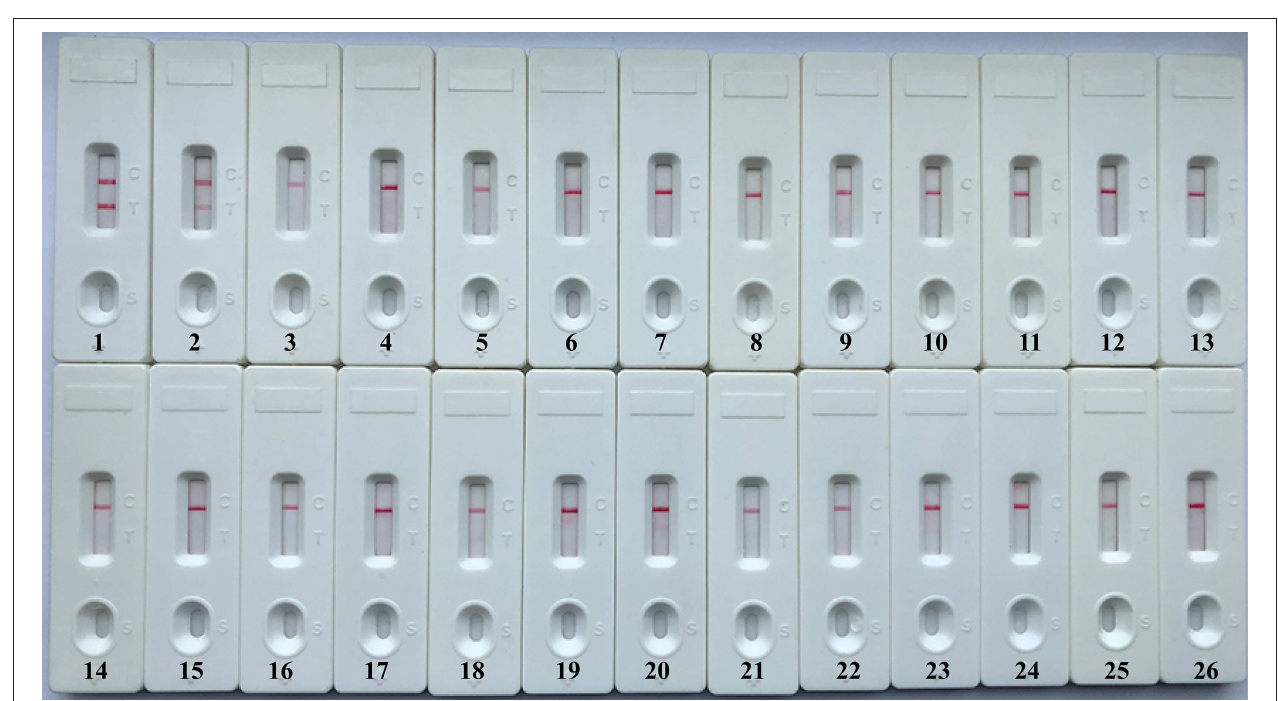
FIGURE 6 | Specificity of uracil-DNA-glycosylase-supplemented polymerase spiral reaction (ATSU-PSR) for identifying Klebsiella pneumoniae . Biosensor 1, K. pneumoniae (ATCC BAA-2146). Biosensor 2, K. pneumoniae (isolate strain). Biosensors 3–25, Streptococcus pneumoniae ; Enterococcus faecalis ; Enterococcus faecium ; Plesiomonas shigelloides ; Staphylococcus epidermidis ; Staphylococcus aureus ; Pseudomonas aeruginosa ; Shigella dysenteriae ; Shigella boydii ; Shigella flexneri ; Shigella sonnei ; Aeromonas hydrophila ; Enterobacter cloacae ; Bntorobater sakazakii ; Campylobacter jejuni ; Enterotoxigenic Escherichia coli ; Listeria monocytogenes ; Listeria innocua ; Vibrio parahaemolyticus ; Acinetobacter baumannii ; Neisseria meningitidis ; Bordetella pertussis ; and Stenotrophomonas maltophilia . Biosensor 26, double distilled water (DW).